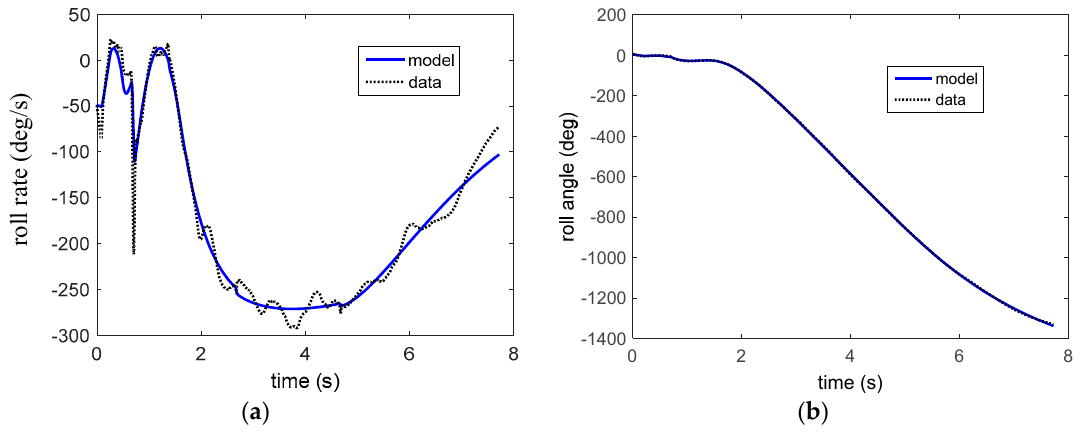
Figure 20. Model response versus data ( a ) Roll angle response; ( b ) Roll rate response.